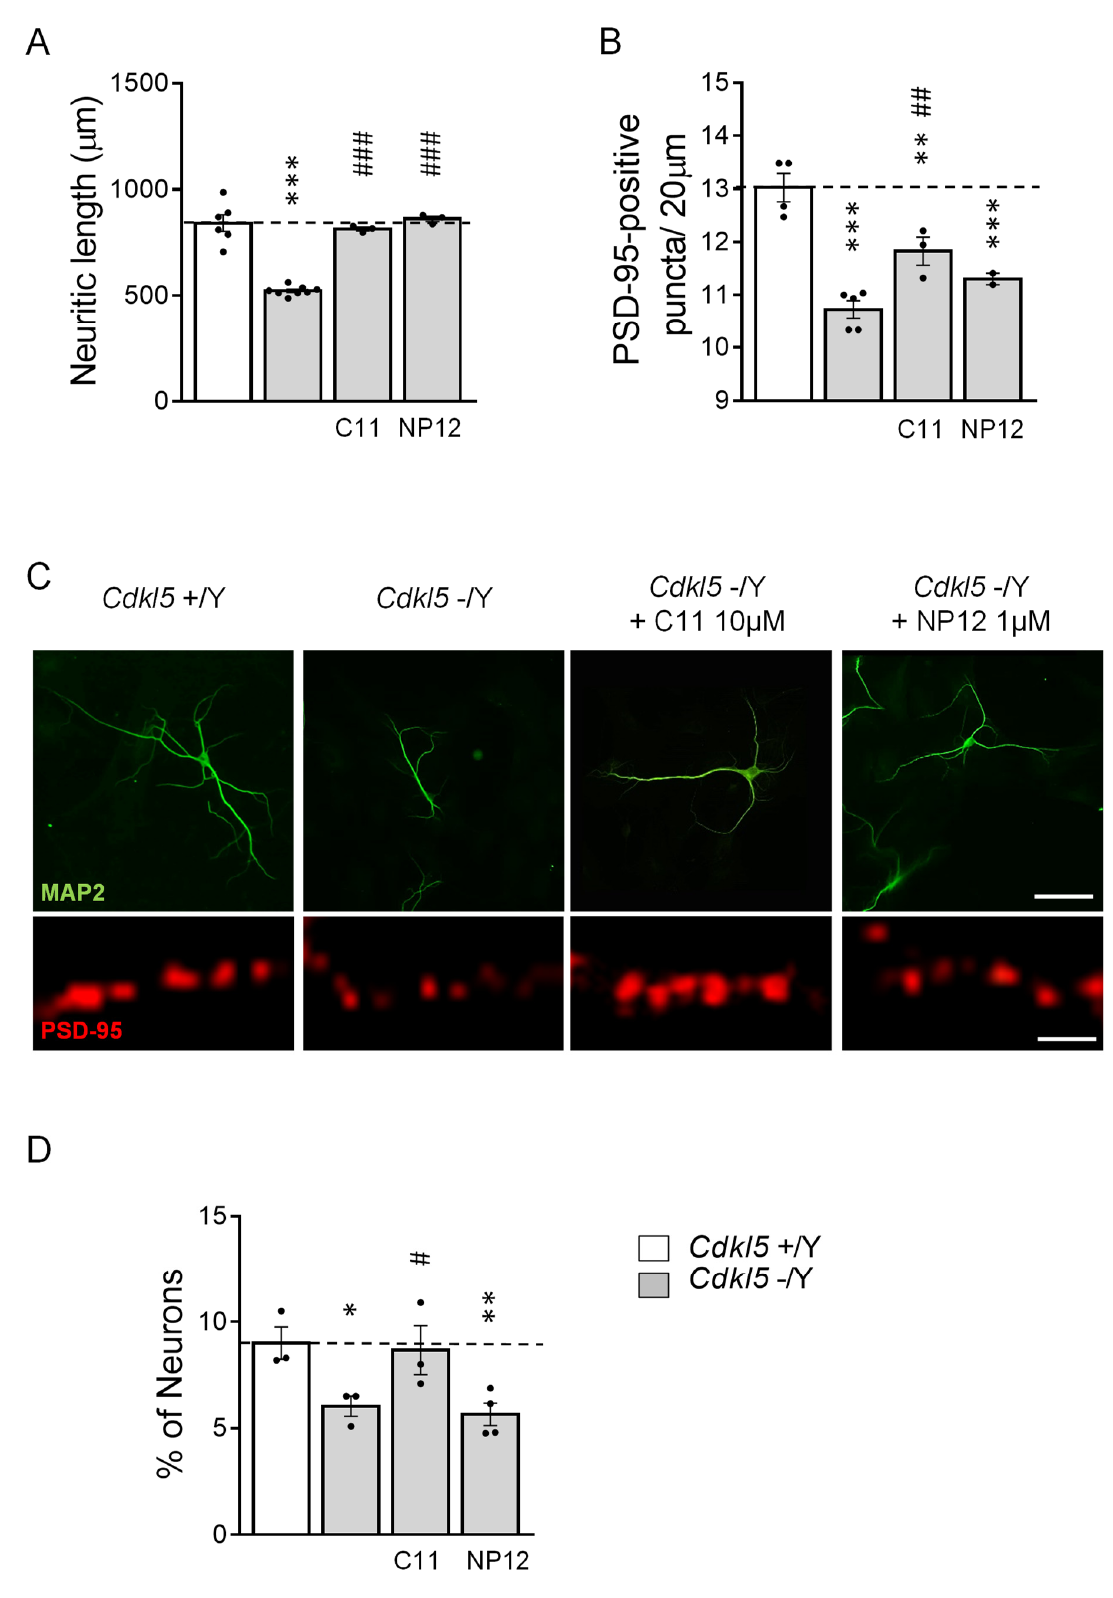
Figure 3. Effect of treatment with C11 on maturation and survival of hippocampal neurons from Cdkl5 KO mice. ( A ) Quantification of the total length of MAP2-positive cells from 10-day differentiated (DIV10) hippocampal neurons. On day 2 post-plating (DIV2) hippocampal cultures were treated with vehicle (0.1% DMSO in PBS; Cdkl5 +/Y; n = 6 and Cdkl5 −